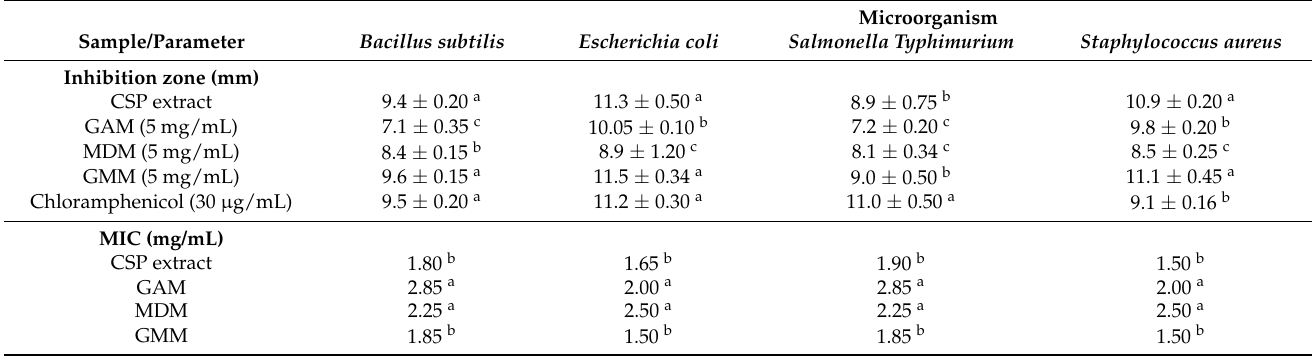
Table 6. Antibacterial activity of CSP extract microcapsules from the optimized ultrasound-assisted extraction. Microorganism Sample/Parameter Bacillus subtilis Escherichia coli Salmonella